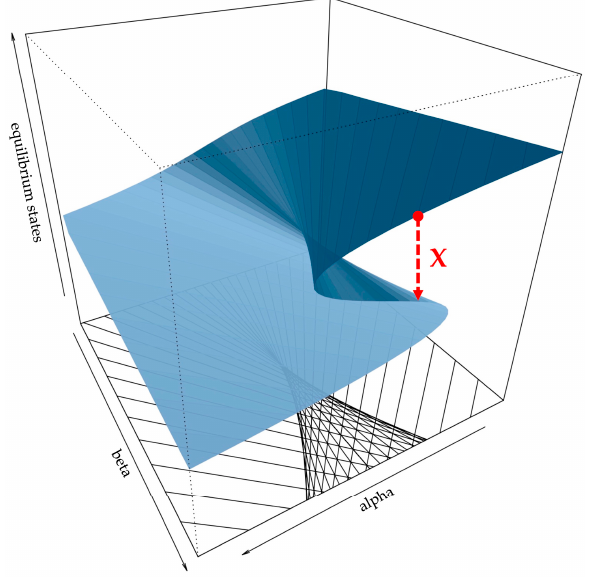
Figure 4. Cusp catastrophe model. The cusp model is a common application of catastrophe theory. It exhibits catastrophe flags such as hysteresis and bifurcation behaviors such as sudden jumps (X). A sudden jump is a phase transition, such as the sudden change in water in a teapot transitioning from liquid to gas. Here, alpha and beta could be temperature and pressure, with equilibrium states being the different conditions the system is attracted to and settles in (i.e., liquid, gas, and solid). Thus, at particular temperatures and pressures, water will jump (X) from liquid to gas. Successful applications of the cusp model include anxiety, beam elasticity, dog aggression, and stock prices [99]. (Modified and reproduced with permission from [106]. CC BY 3.0.).